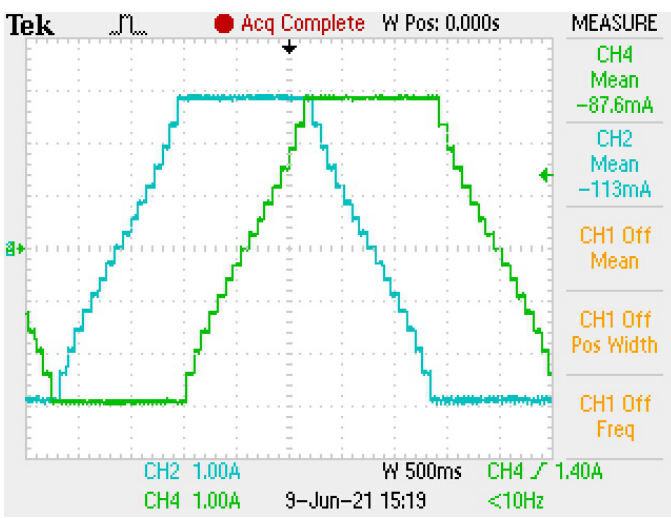
Figure 14. A–B coil currents in the quadrature control scheme with resolution